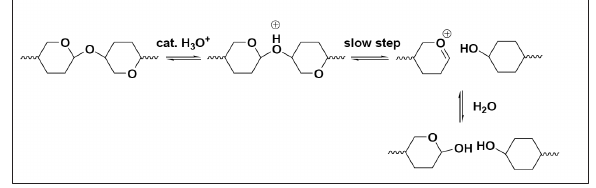
Figure 5: Proposed mechanism for acid-catalysed hydrolysis of cellulose.